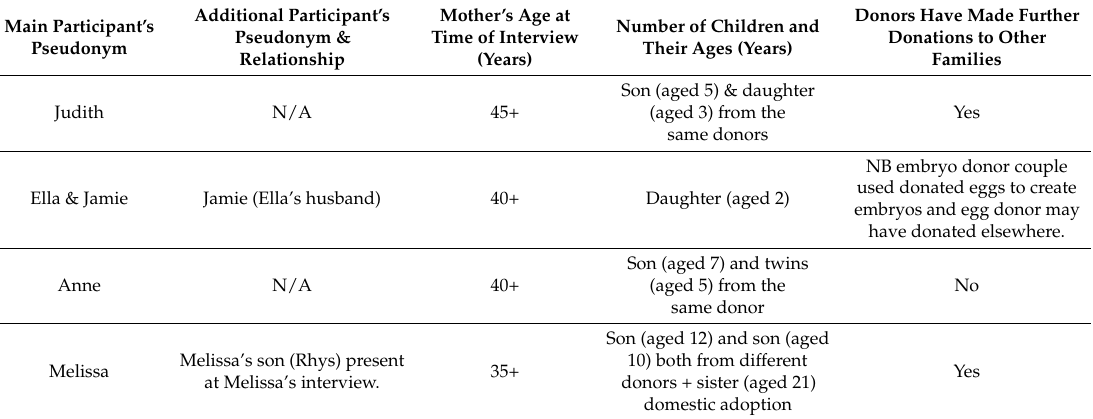
Table 1. Summary of participant